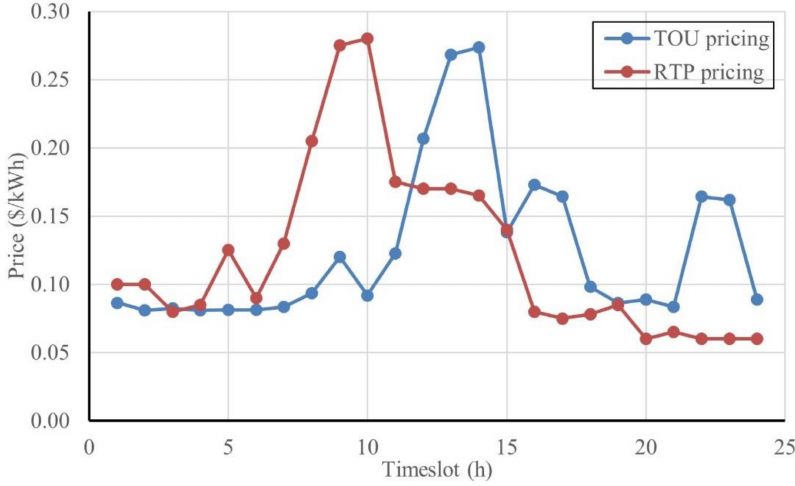
Figure 4. Pricing for each hour for RTP and